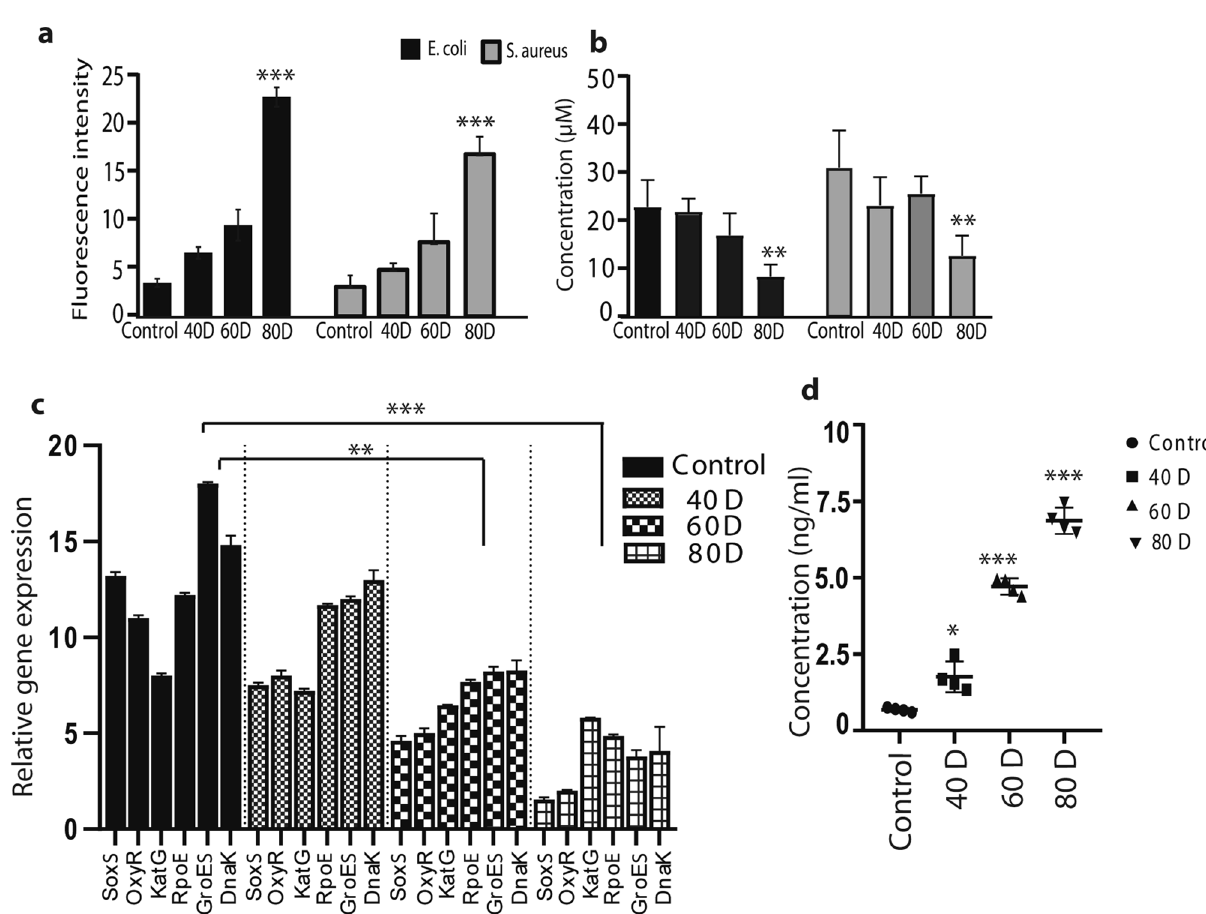
Figure 7. Analysis of ( a ) intracellular RONS levels, ( b ) intracellular glutathione (GSH) level, ( c ) oxidative- related gene expressions, and ( d ) quantification of 8 ‐ hydroxy ‐ 2 ′ ‐ deoxyguanosine (8 ‐ OHdG), after various discharges of microwave radiation. All values are expressed as mean ± SD in triplicate. Student’s t-test was performed for the statistical analysis (* P < 0.05, ** P < 0.01, and *** P <